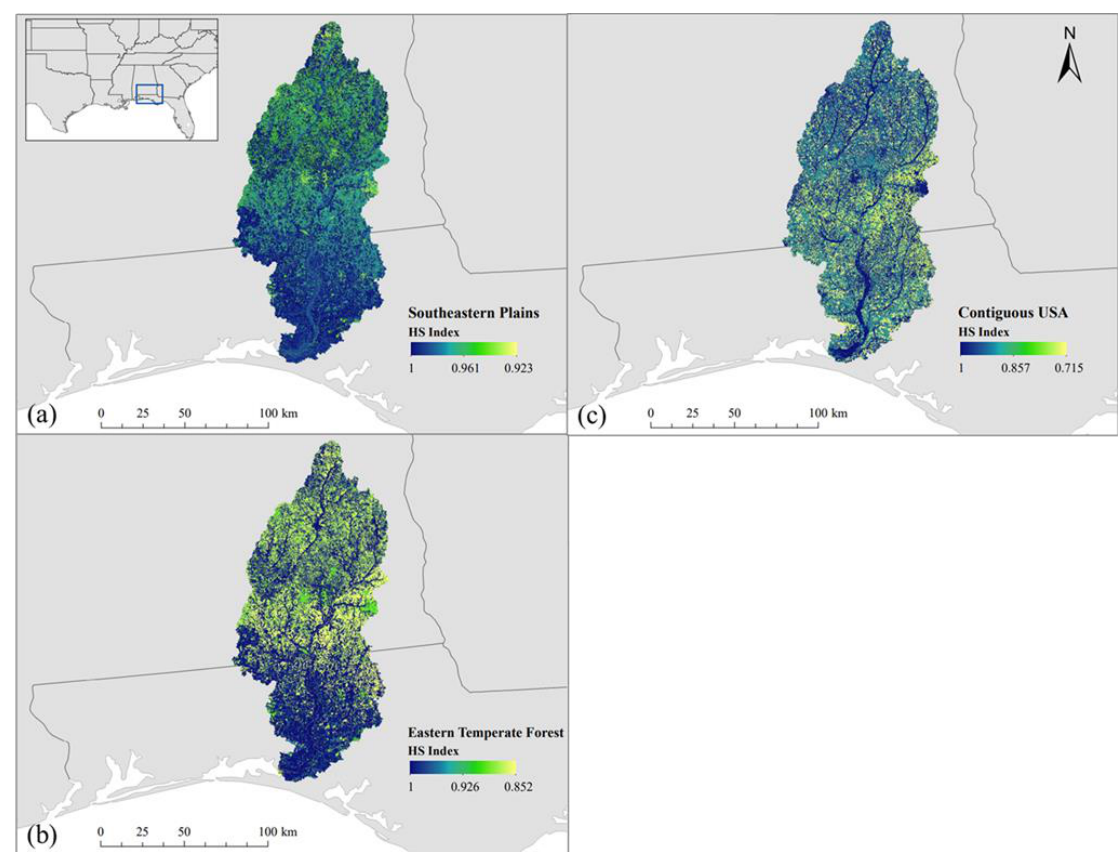
Figure 6. The habitat suitability maps of the Choctawhatchee Watershed based on species richness derived from averaging the values within regions of varying sizes. Maps created using the average values from grid cells in the ( a ) Southeastern Plains ecoregion; ( b ) Eastern Temperate Forest ecoregion; ( c ) contiguous USA.